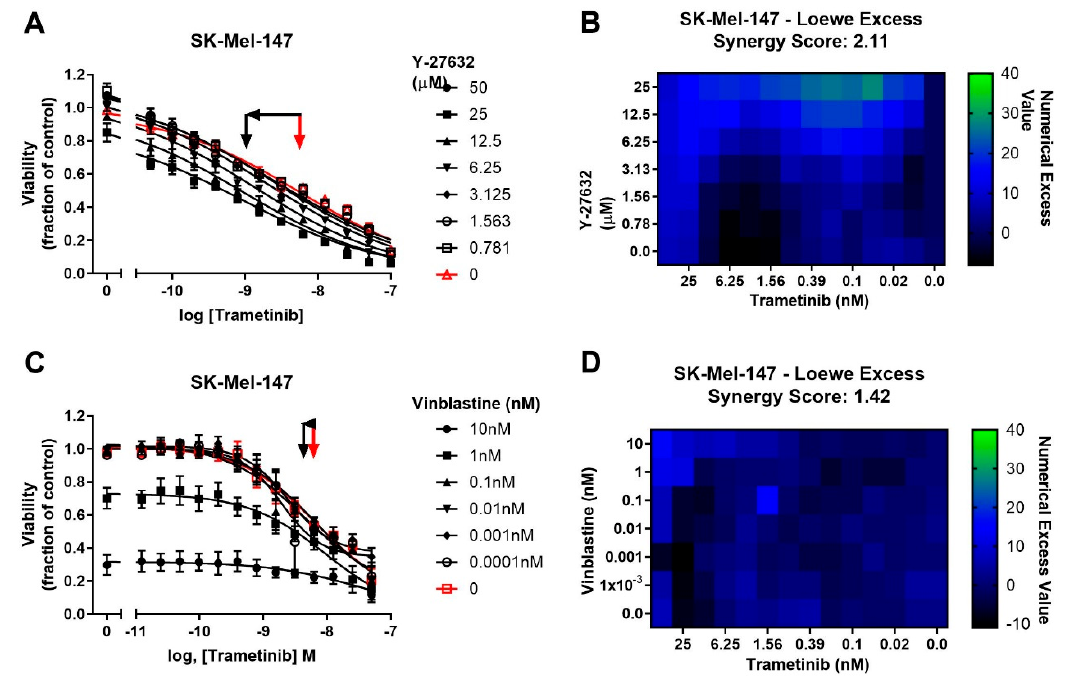
Figure 5. Potentiation of trametinib action is specific to the Rho/MRTF-pathway mechanisms. ( A ). Sensitivity to trametinib in combination with the ROCK inhibitor Y-27632. Combination treatments were determined in the same manner as described in Figure 3A.The reported values are expressed as the fraction of luminescence over vehicle control for three independent experiments. ( B ). Loewe Excess was calculated as a metric of synergistic effects of the combination treatments as described in Methods (Section 4.2). Values represent the mean of three independent experiments (n = 3). ( C ). Sensitivity to trametinib in combination with Vinblastine. Combination treatment was determined in the same manner as in Figure 5A. ( D ). Loewe Excess was determined as described in Methods (Section 4.2). Values represent the mean of three independent experiments (n = 3).